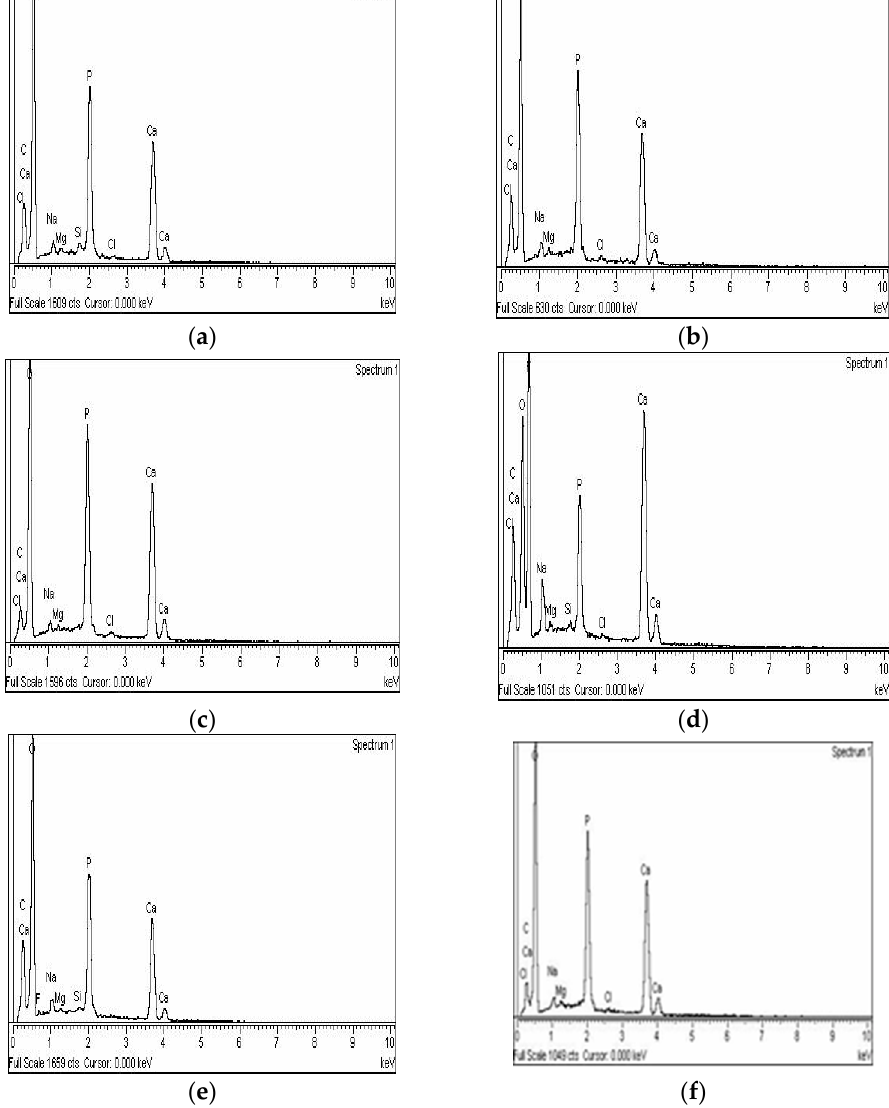
Figure 3. Representative results of EDS elemental analysis, following demineralization and remin- eralization of the samples treated with 3M™ Clinpro™ White Varnish ( a , b ), MI Varnish® ( c , d ) and Megasonex® ( e , f ).